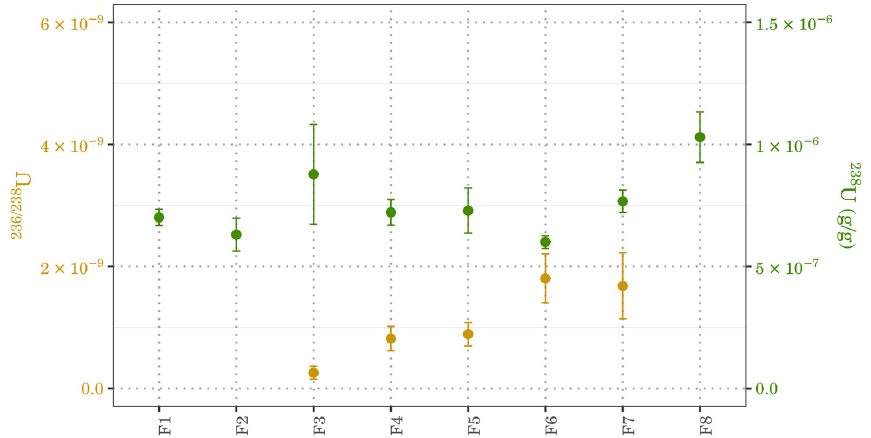
Figure 4. 236/238 U isotopic ratio (in orange, on the left) and 238 U concentration (in green, on the right) measured in river sediments. Values below the detection limit are not shown.